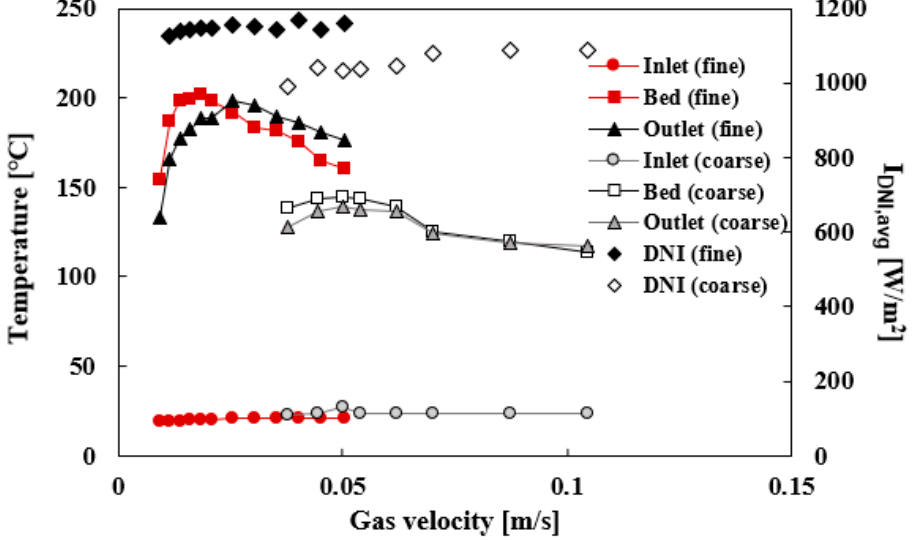
ff ect of gas velocity on temperatures of bed and outlet gas in the particle Figure 4. Effect of gas velocity on temperatures of bed and outlet gas in the particle receiver. Figure 4. E